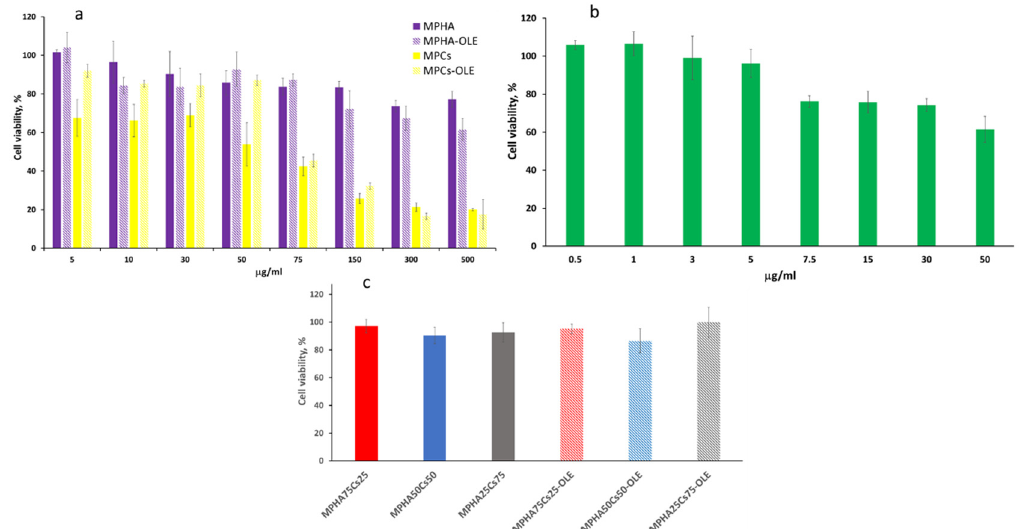
Figure 7. BALB/3T3 clone A31 murine embryonic fibroblast cell viability after 4 h of incubation with ( a ) MPHA, MPHA- OLE, MPCs, MPCs-OLE; ( b ) free OLE; ( c ) mixtures of MPHA and MPCs medicated or not (30 µg/mL total MP concentration). Data are expressed as % viable cells compared to 100% of control (untreated cells). Means ± SD ( n = 8).